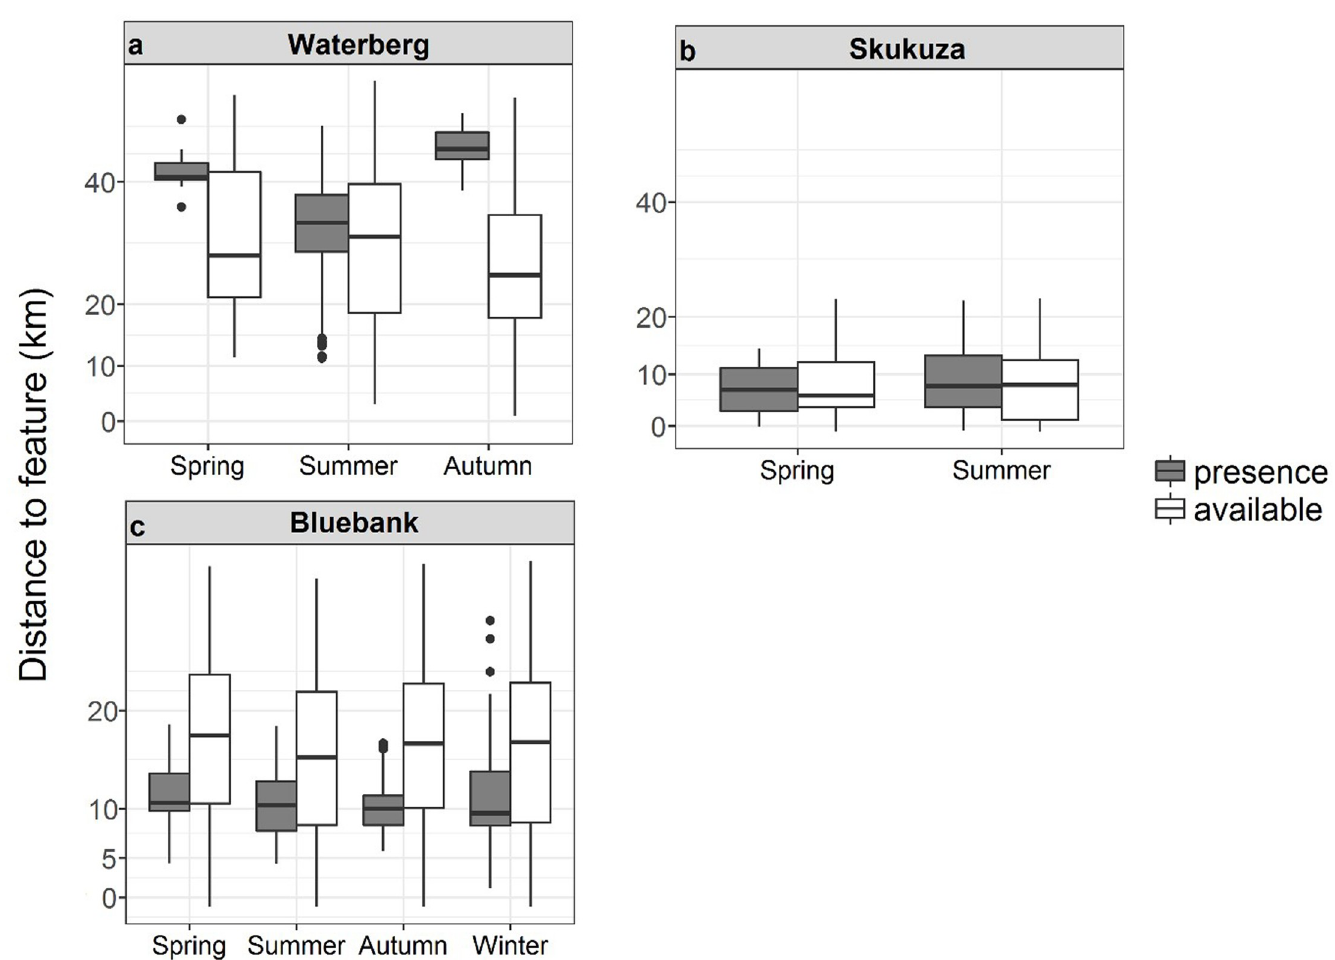
Fig 6. African wild dog pack presence and availability data in areas of different human land use feature types for the a) Waterberg, b) Skukuza and c) Bluebank packs across different seasons in the Limpopo and Mpumalanga Provinces, South Africa. Boxplots show medians (dark horizontal bars), 1 st and 3 rd interquartiles (boxes), 95% CI (whiskers) and outliers (dots). Presence data are indicated by coloured boxes.